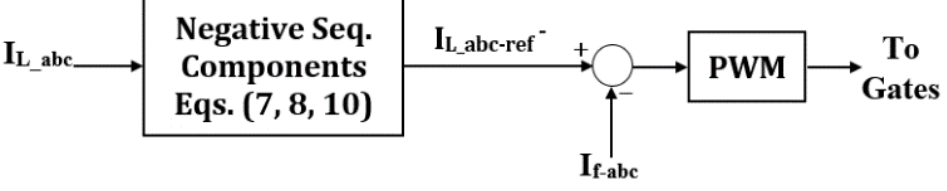
Figure 3. Generation of the inverter gate drive signals.